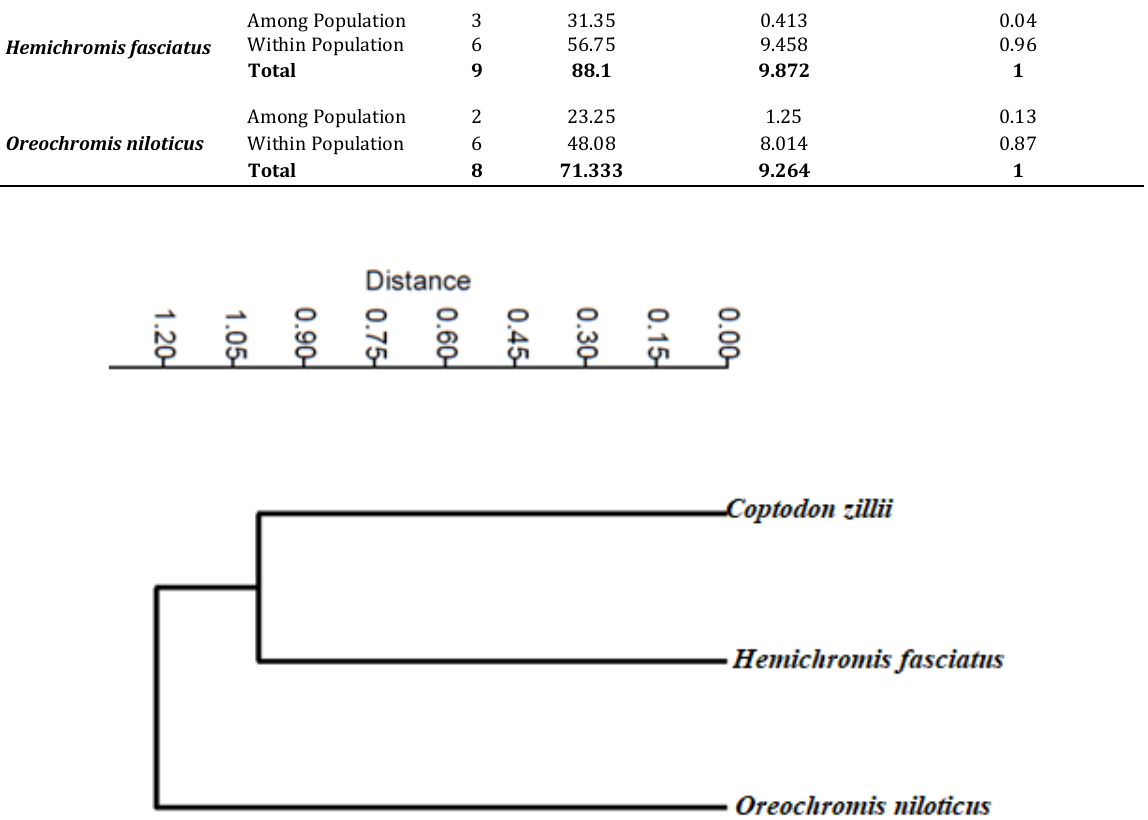
Figure 4. Dendrogram ofC. zillii, H. fasciatus and O.